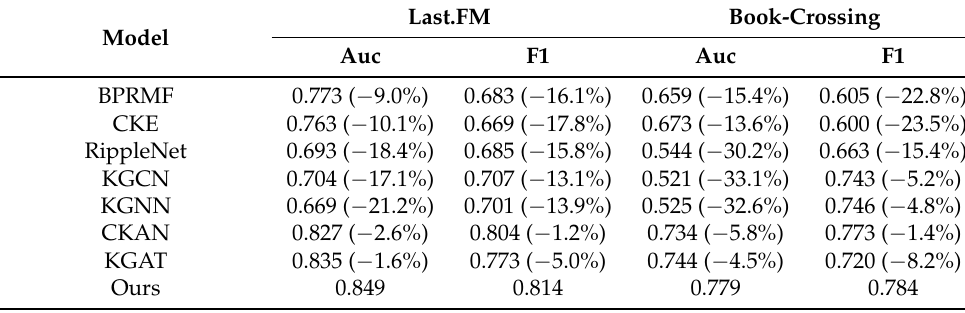
Table 3. Overall performance comparison.